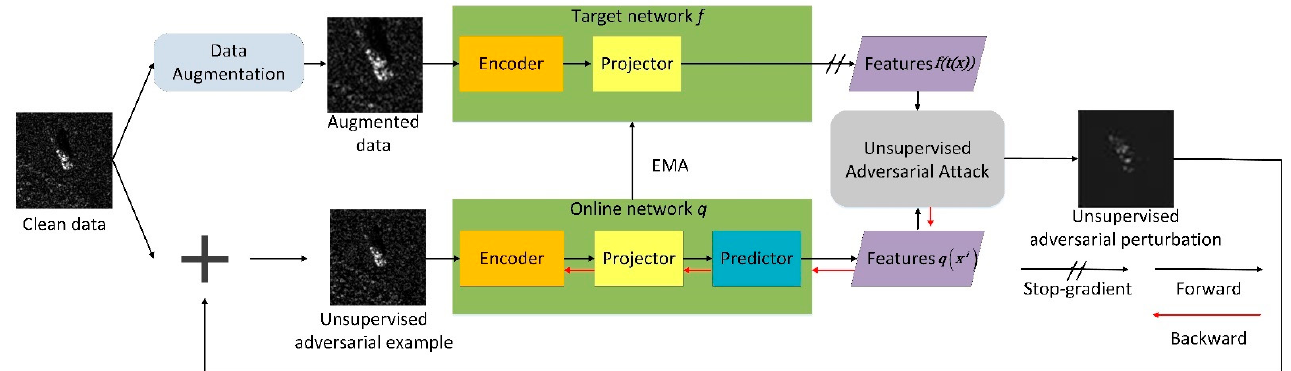
Figure 4. Illustration of UACL’s architecture. We minimize the similarity loss between the features of augmented data and the corresponding unsupervised adversarial examples to optimize the Siamese network. EMA means exponential moving average. At the end of training, everything but the robust encoder, i.e., the ResNet18, is discarded.